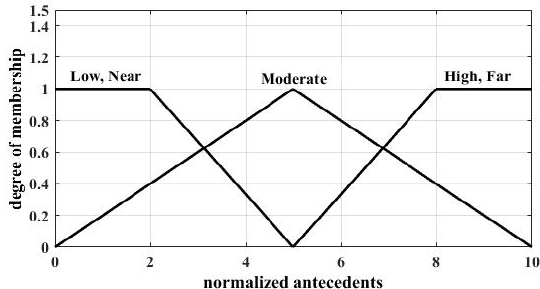
Figure 2. MFs for normalized antecedents.